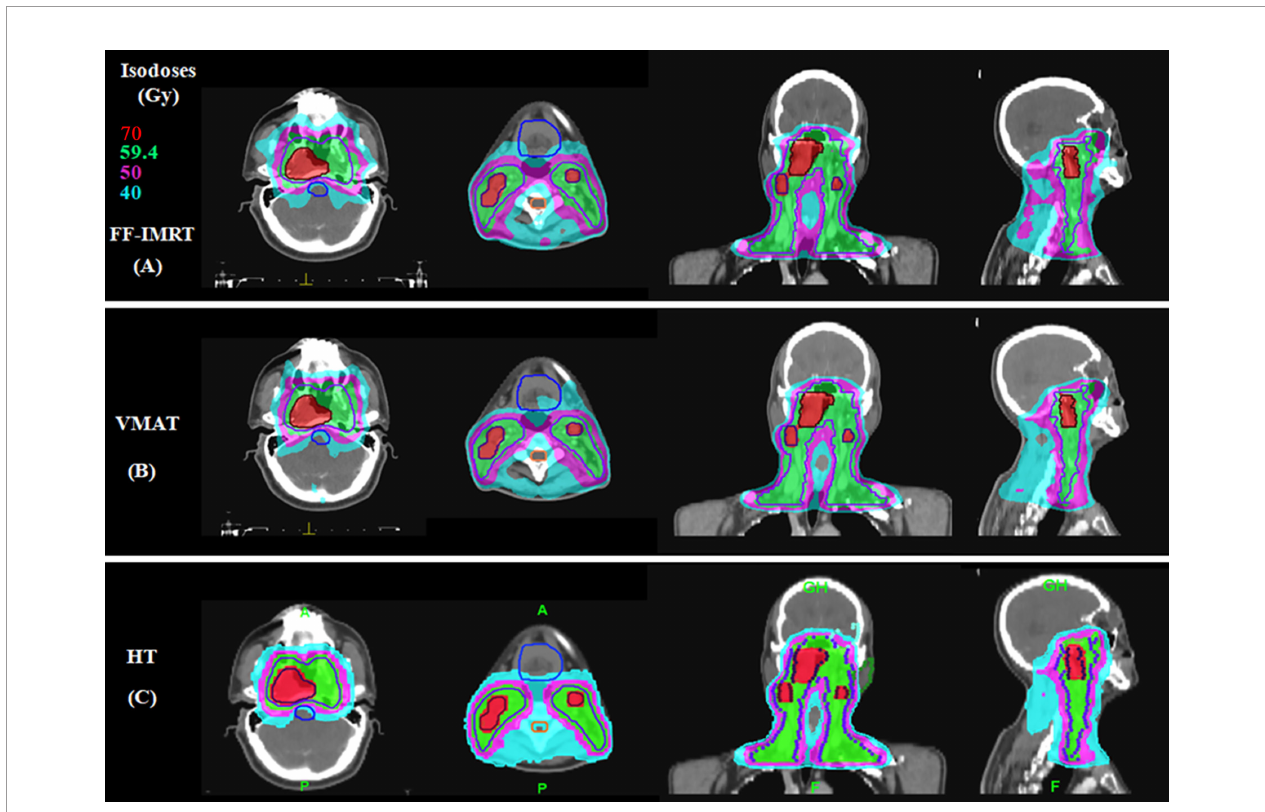
FIGURE 2 | Typical dose distributions for the three plans in locally advanced nasopharyngeal carcinoma (NPC). (A) Fixed- fi eld intensity-modulated radiation therapy (FF-IMRT), (B) volume-modulated arc therapy (VMAT), and (C) helical tomography (HT)